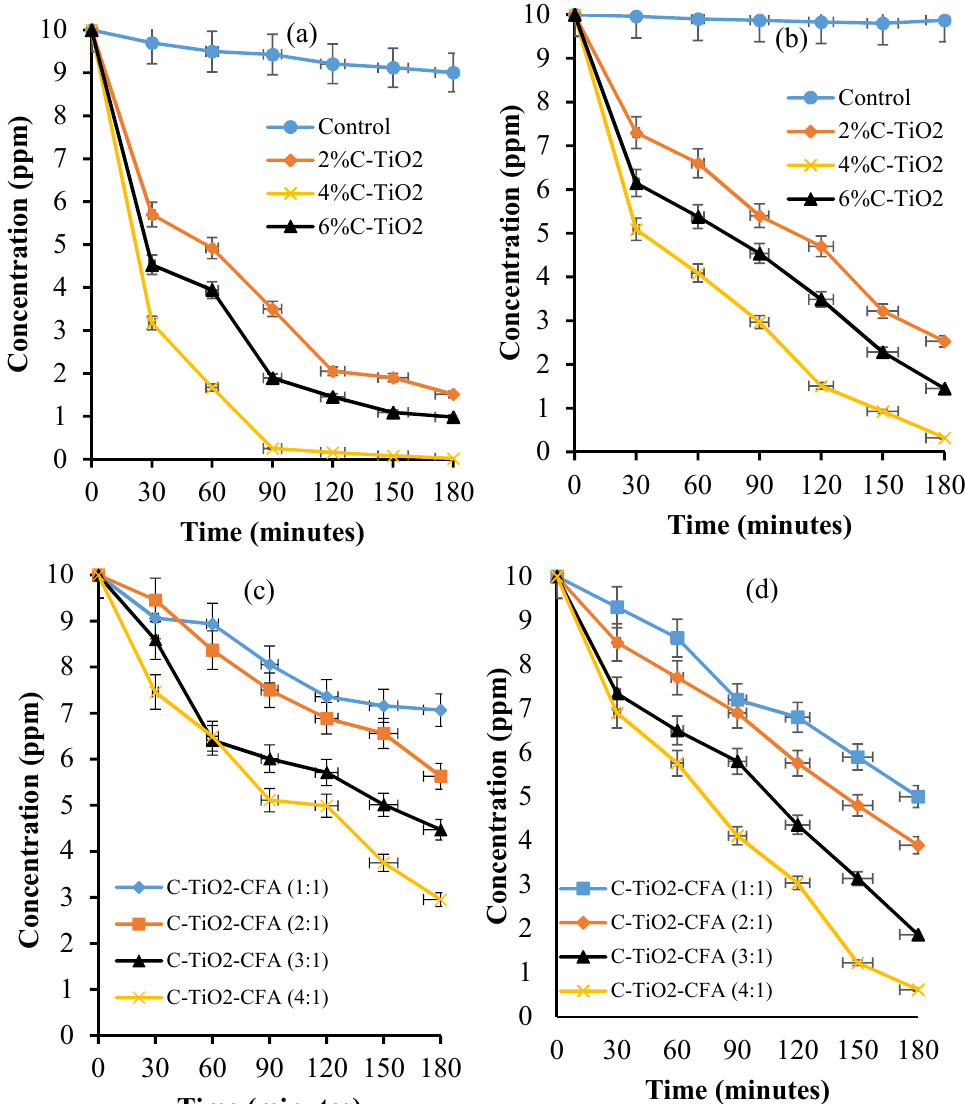
Figure 6. Degradation profiles of MO and GY, using ( a , b ) C-TiO 2 with di ff erent concentrations of carbon dopant (2%, 4%, and 6%); ( c , d ) di ff erent ratios of C-TiO 2 : CFA (4:1, 3:1, 2:1, and 1:1), respectively. A catalyst loading of 1 gL − 1 was used, and the volume of the dye polluted water was 100 mL, with a concentration of 10 ppm. The average light intensities were 90,800 and 106,600 lux for MO and GY degradation experiments, respectively.